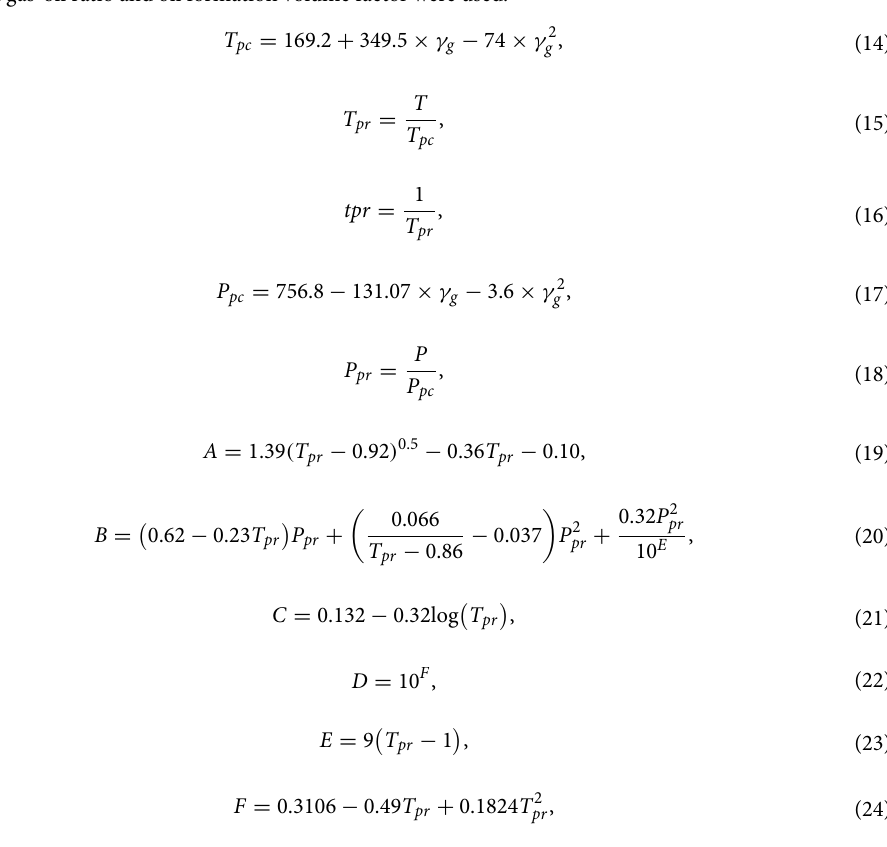
temperature and pressure, Brill and Beggs’ correlation 37 for compressibility factor, and Standing’s correlation 38 for solution gas-oil ratio and oil formation volume factor were used.